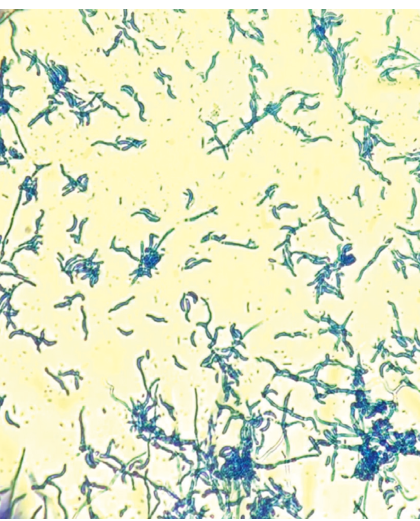
Figure 1: Sickle-shaped, multicell macroconidia (40x) of Fusarium species stained with lactophenol cotton blue counterstain from a perinephric fluid